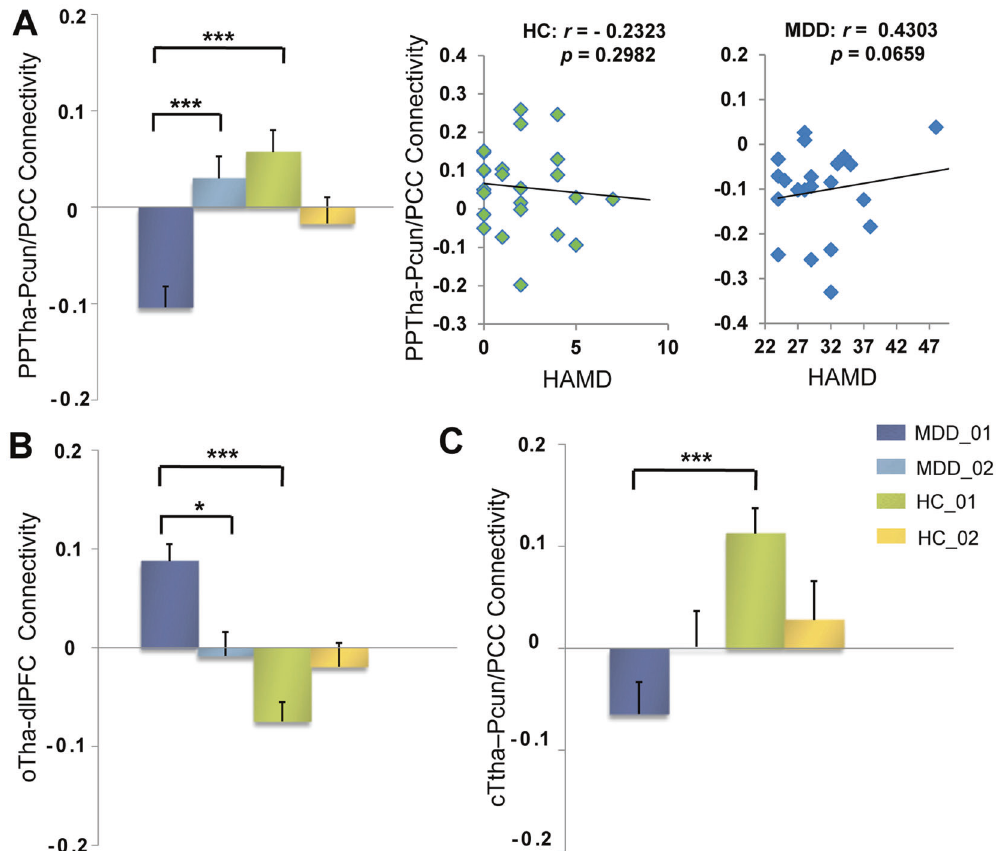
Fig. 2 Functional connectivity showing signi fi cant differences in MDDs and HCs before BMRM. A Functional connectivity between the left posterior parietal thalamus (PPTha) and the bilateral precuneus/post cingulate cortex (Pcun/PCC) and its correlation with HAMD in HCs and MDDs. B Functional connectivity between the left occipital thalamus (oTha) and the left dorsolateral prefrontal cortex (dlPFC). C Functional connectivity between the left caudal temporal thalamus (cTha) and the bilateral precuneus/post cingulate cortex. HAMD Hamilton